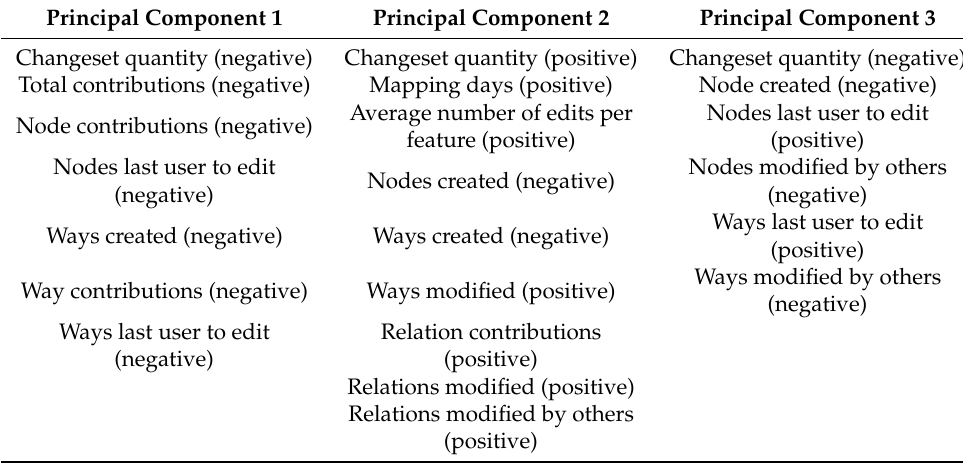
Table 5. Characterising the principal components.